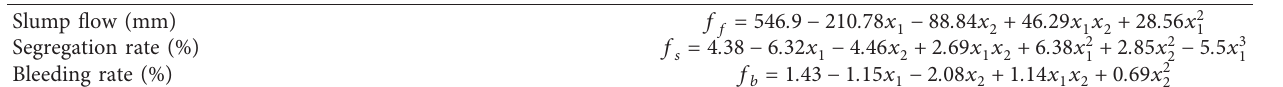
Table 5: Regression